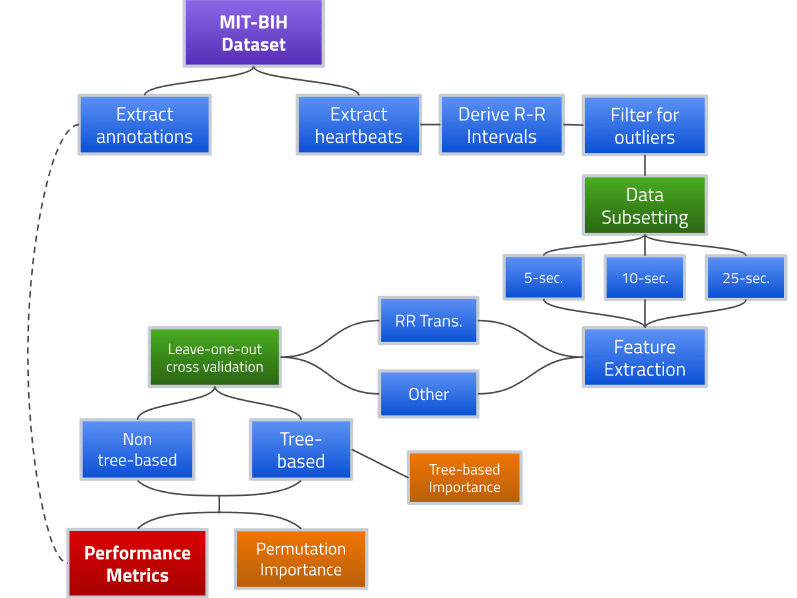
Figure 2. AFib detection framework using R-R interval transition matrix